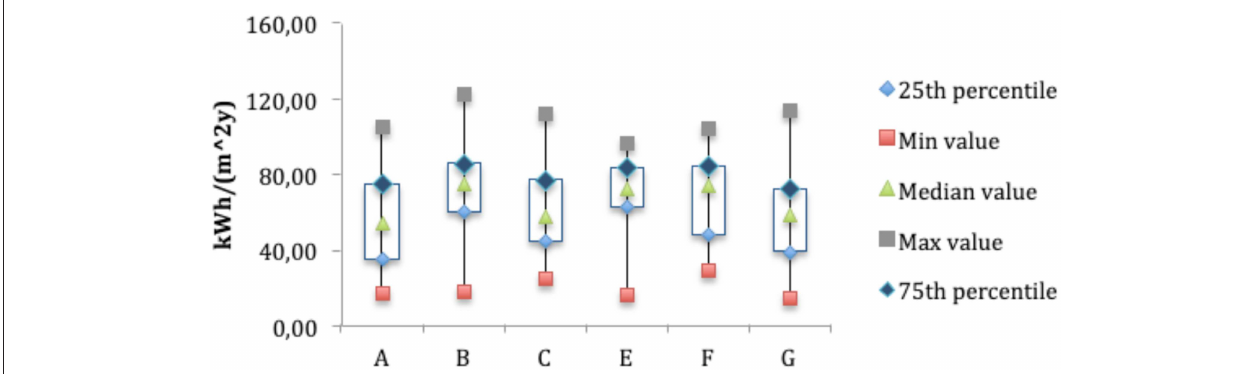
FIGURE 3 | Actual thermal energy consumption for heating (2016 October 15th − 2017 April 15th).